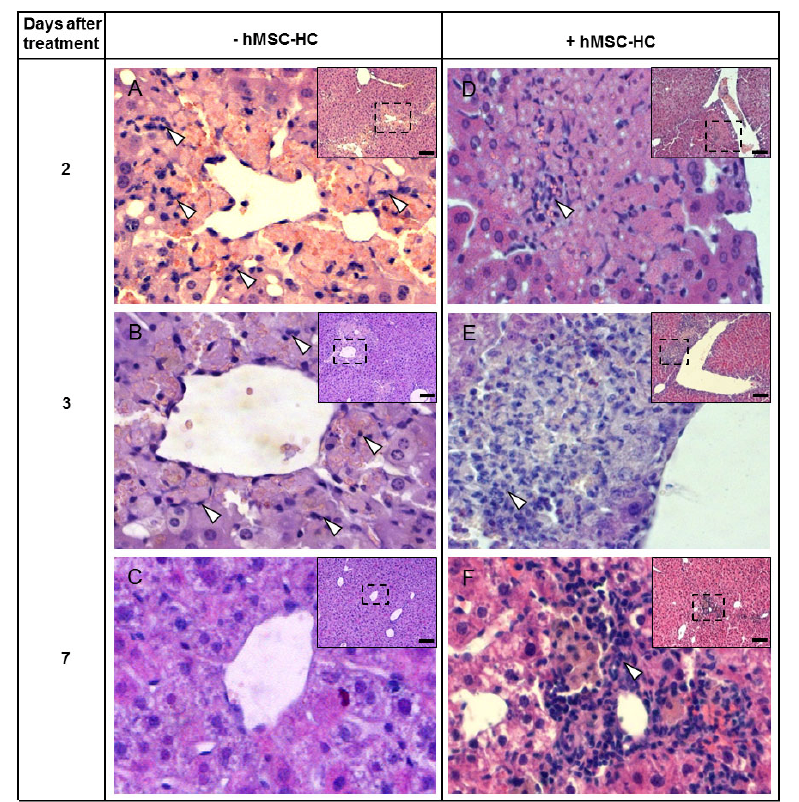
Figure 10. Infiltration of inflammatory cells in livers of mice after APAP